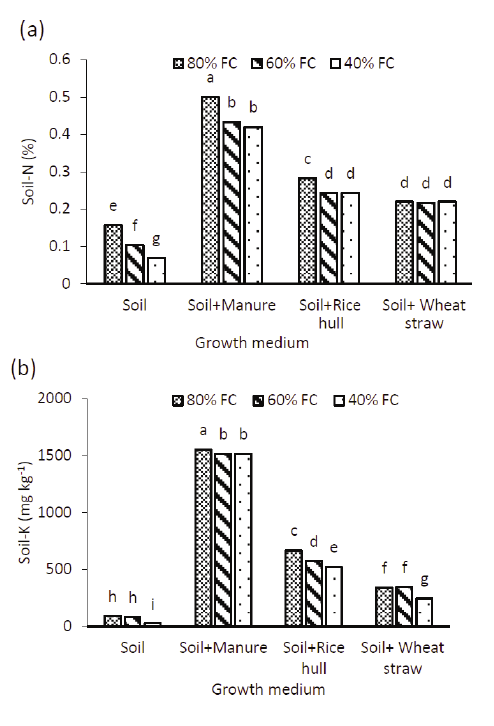
Fig. 2 ­ The soil­N (a) and soil­K (b). Values in columns followed by the same letter are not significantly different at the 0.05 level (P≤0.05).